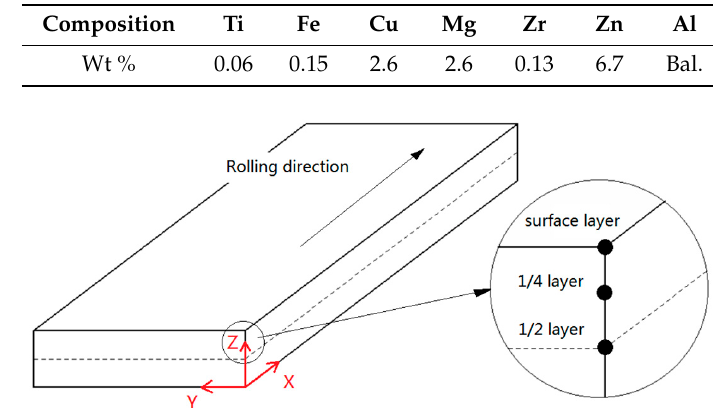
Table 2. The chemical composition of aluminum alloy 7050.